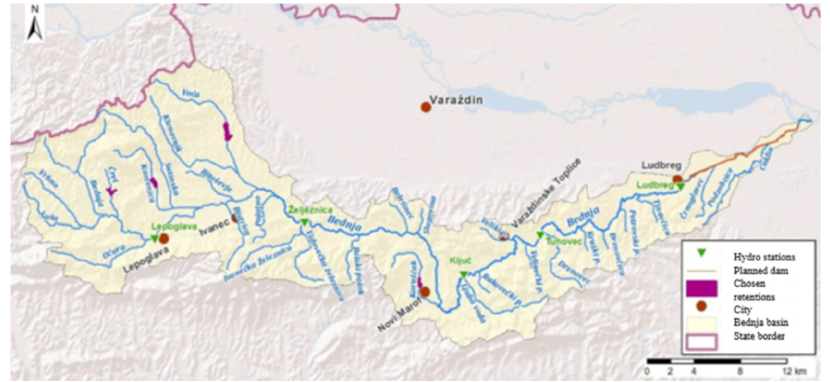
Figure 2. Water catchment with the tributaries of the river Bednja [19].